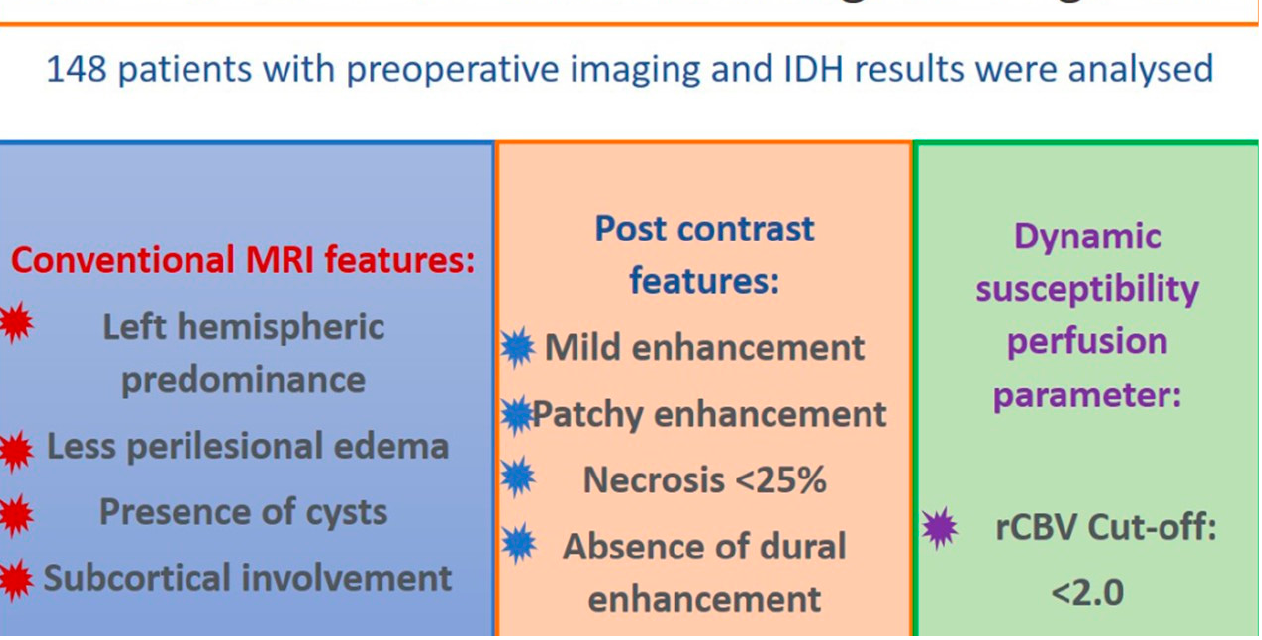
Figure 11. ( a , b ) Representative MR axial T1 + C images show dural enhancement along the right frontoparietal convexity in IDH-wildtype tumor.